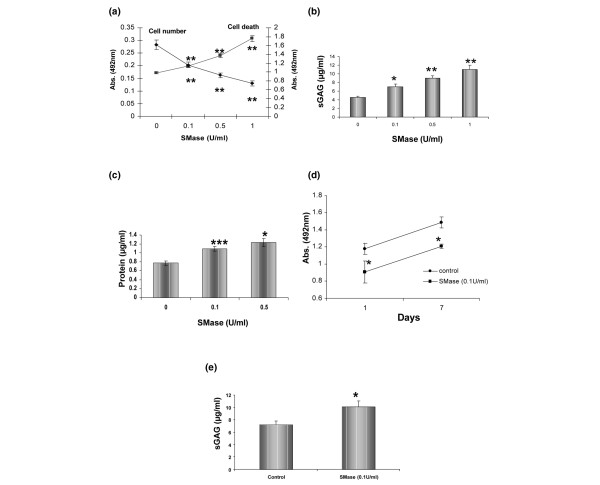
Effect of sphingomyelinase on chondrocyte function. (a) Sphingomyelinase treatment dose dependently induces cell death and decreases cell number. Chondrocytes were cultured for 24 hours in the presence of SMase (0–1.0 U/ml). Cell death and cell number were assessed using the CytoTox 96® assay (Promega), which quantitatively measures lactate dehydrogenase released into the media upon cell death during the culture period or upon lysis of living cells at the end of the culture period. Data shown are mean absorbance units (492 nm) ± standard error. ** P < 0.01 versus control. (b) Short-term SMase treatment induces proteoglycan release from articular chondrocytes. Chondrocytes were cultured for 24 hours in the presence of SMase (0–1.0 U/ml). Media was analyzed for release of sGAGs using the DMMB assay. Differences in release of sGAG associated with culture treatment are expressed as mean sGAG released per cell (mg/ml) ± standard error. * P < 0.05; ** P < 0.01. (c) SMase dose dependently increases cellular protein content. Following 24 hours of treatment with increasing doses of SMase, cells (with cell-associated matrix proteins) were solubilized with 0.9% Triton X-100 and the protein content (mg/ml) determined using the BCA assay (Pierce). Data are presented as mean ± standard error. * P < 0.05; *** P < 0.001, versus control. (d) Long-term SMase treatment reduces cell proliferation. Chondrocytes were cultured for 1–7 days and the effect of SMase (0.1 U/ml) on cell number determined using the CytoTox® assay. Data shown are mean absorbance units (492 nm) ± standard error. * P < 0.05 versus control at equivalent time point. (e) Long-term SMase treatment induces proteoglycan release from articular chondrocytes. Chondrocytes were cultured in the presence of SMase (0.1 U/ml) for 7 days. The amount of sGAG released into the media per cell was determined as above. Data are presented as mean ± standard error. * P < 0.05. DMMB, dimethylmethylene blue; sGAG = sulphated glycosaminoglycan; SMase, sphingomyelinase.